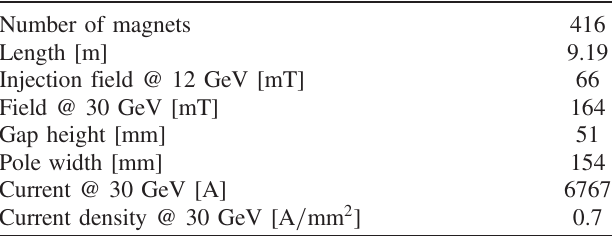
TABLE IV. Main parameters of the HERA resistive dipoles.